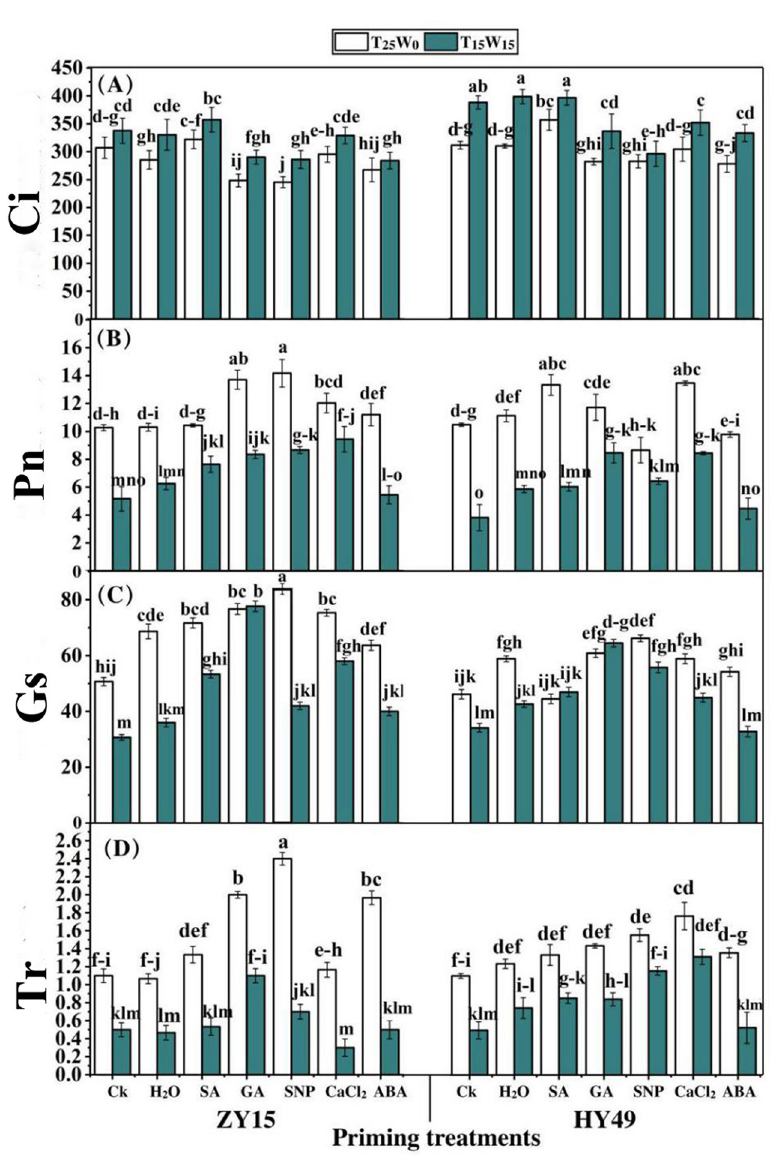
Fig 1. Effects of priming agents on the photosynthetic characteristics of rape seedlings under low temperature and drought conditions. The effects of low temperature and drought stresses (25˚C and 0 MPa, 15˚C and -0.15 MPa) on the photosynthetic characteristics: ( A ) intercellular carbon dioxide (Ci), ( B ) net photosynthesis (Pn), ( C ) stomatal conductance (Gs), and ( D ) transpiration rate (Tr) of Brassica napus seedlings (varieties ZY15 and HY49). Seven different treatments ( a ) control (Ck), ( b ) water (H 2 O), ( c ) salicylic acid (SA), ( d ) gibberellic acid (GA), ( e ) sodium nitroprusside (SNP), ( f ) calcium chloride (CaCl 2 ), and ( g ) abscisic acid (ABA) were evaluated. Each point represents the mean of three replicates. The values presented are the mean ± standard deviation (SD). Significant differences among treatments were determined using a three-way analysis of variance (ANOVA) (p < 0.05 according to Duncan’s multiple range